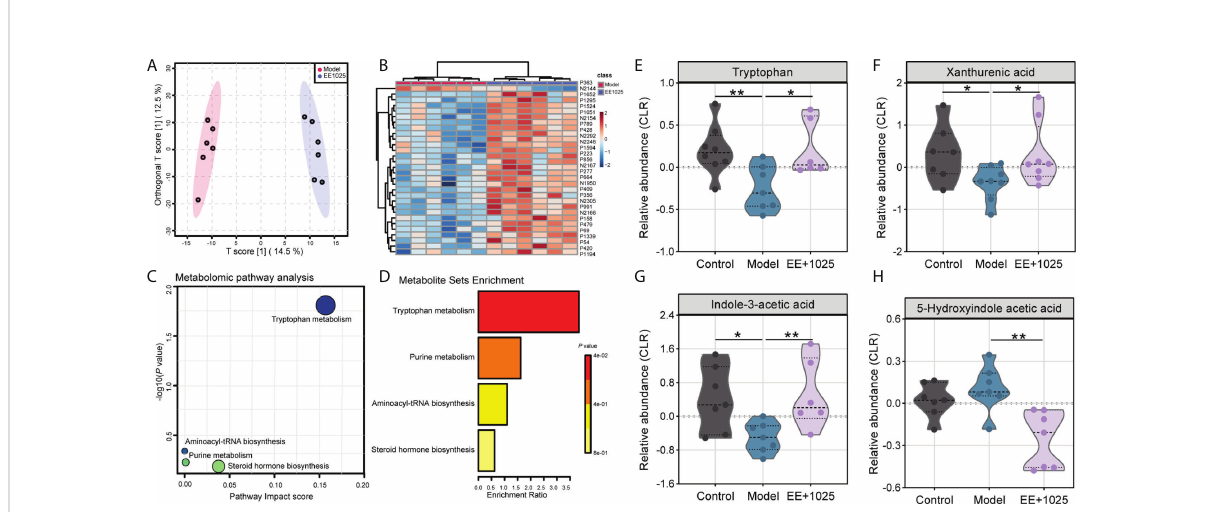
FIGURE 6 EE combined with B. breve CCFM1025 treatment regulates microbial metabolites in A b -injected model mice. (A) OPLS-DA score plot between model and EE + B. breve CCFM1025 groups. (B) Hierarchical cluster analysis of differential metabolites between model and EE + ( B ) breve CCFM1025 groups in fecal samples (top 30). The name of differential metabolites was listed in Supplementary Table 2. (C) Scatterplot showing results of MetaboAnalyst Pathway analysis using the Mus musculus (mouse) pathway library. (D) Overview of metabolite set enrichment in feces according to the KEGG database. (E – H) The relative abundance of tryptophan metabolites tryptophan, xanthurenic acid, indole-3-acetic acid, and 5-hydroxyindole acetic acid. The y axis shows CLR-transformed metabolite concentrations. Black horizontal dashed lines in violin plots depict medians, the bottom and top lines represent, respectively, the 25th and 75th percentile. * P < 0.05, ** P < 0.01 as determined by Mann – Whitney